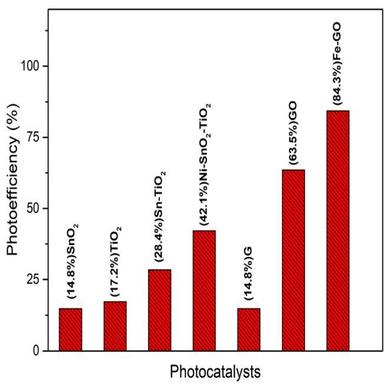
Bar Chart Depicting Photo-Efficiencies Utilizing Different Prepared Photocatalysts.